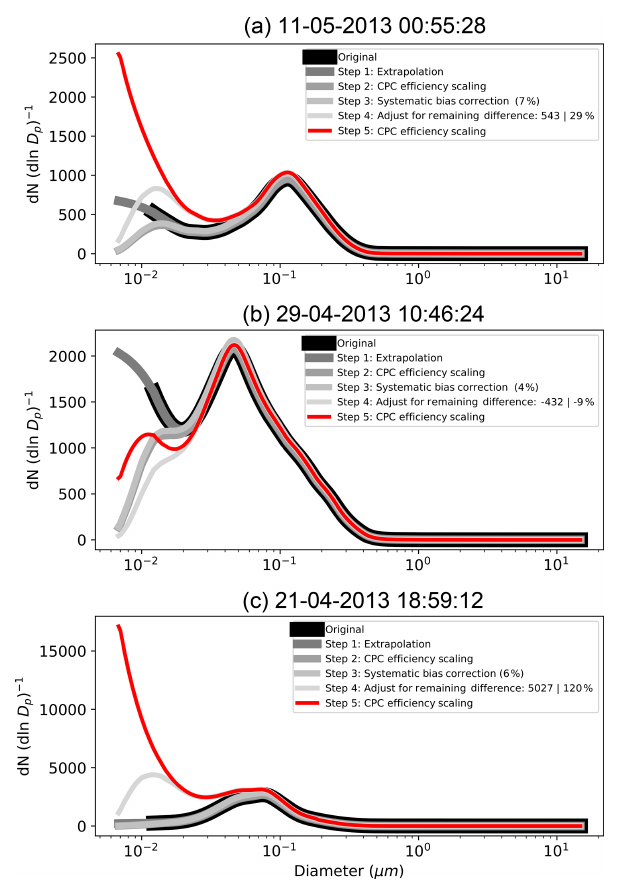
Figure A1. Three examples of the adjustments made to the origi- nal TDMA aerosol number size distributions and the final aerosol number size distribution post-adjustments (red).